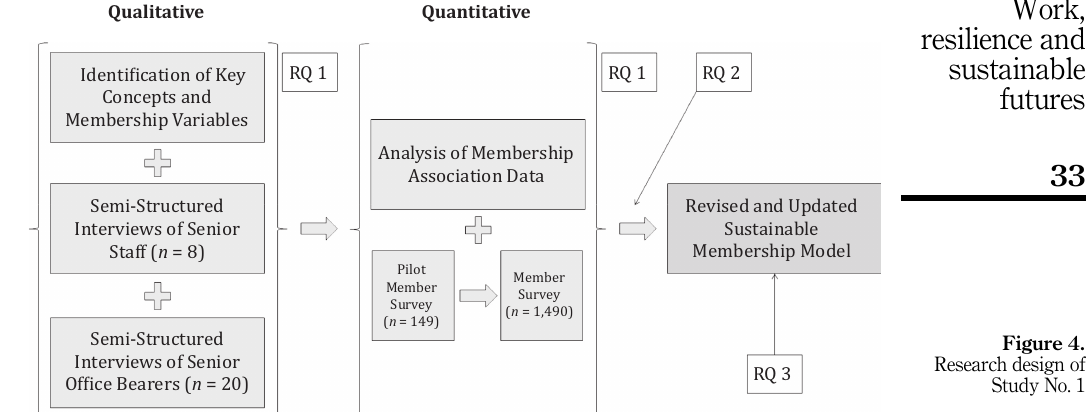
Figure 4. Research design